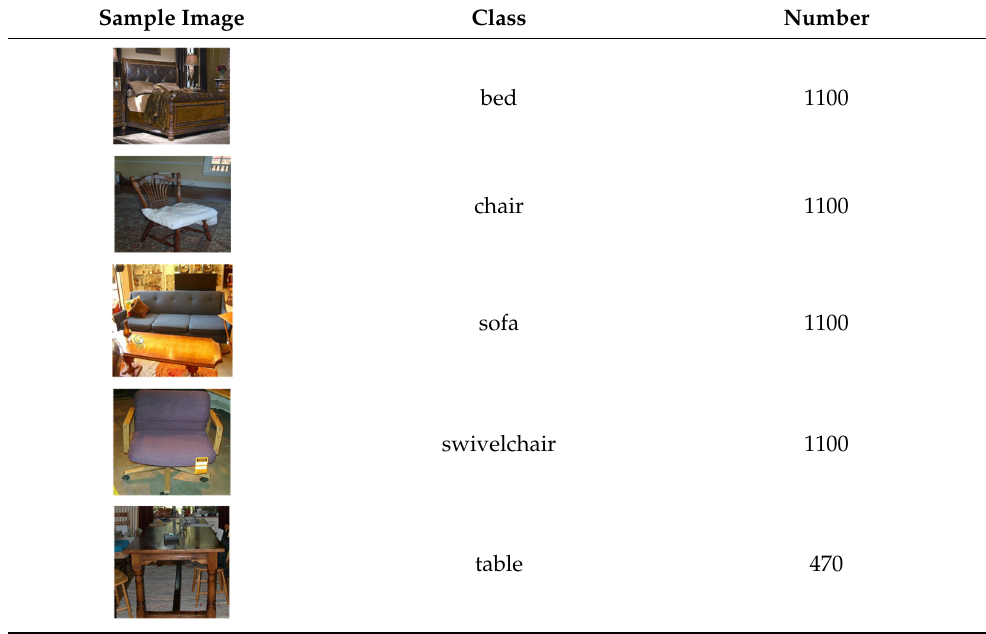
Figure 5. The samples of the furniture dataset. ( a ) bed. ( b ) chair. ( c ) sofa. ( d ) swivelchair. ( e ) table. Table 1. The description of furniture dataset.